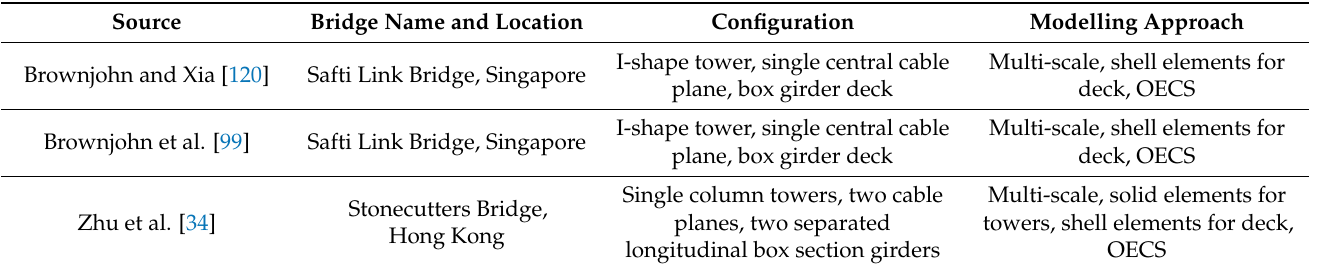
Table 4. Other modelling approaches.